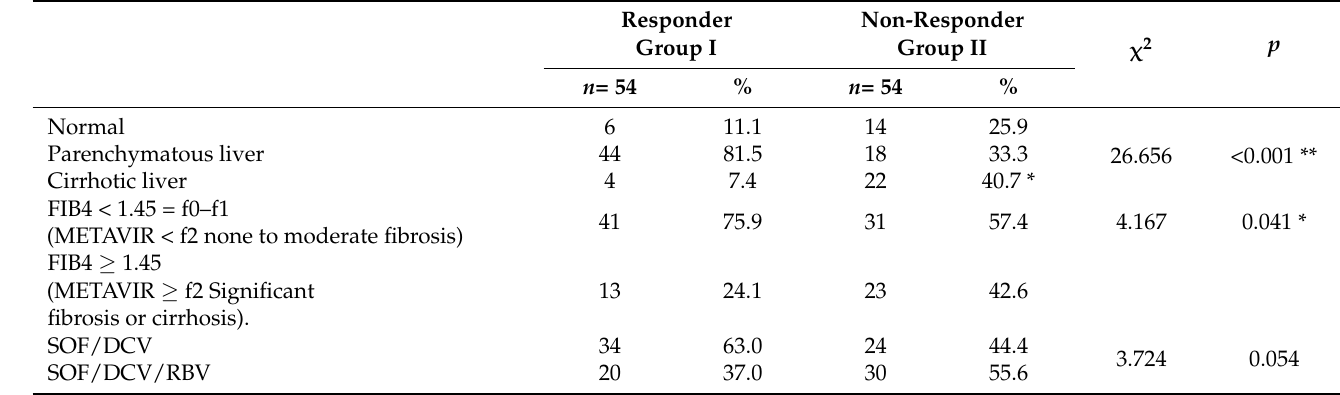
Table 2. Ultrasound (US) findings of the liver, FIB4, and treatment protocol among studied groups. Responder